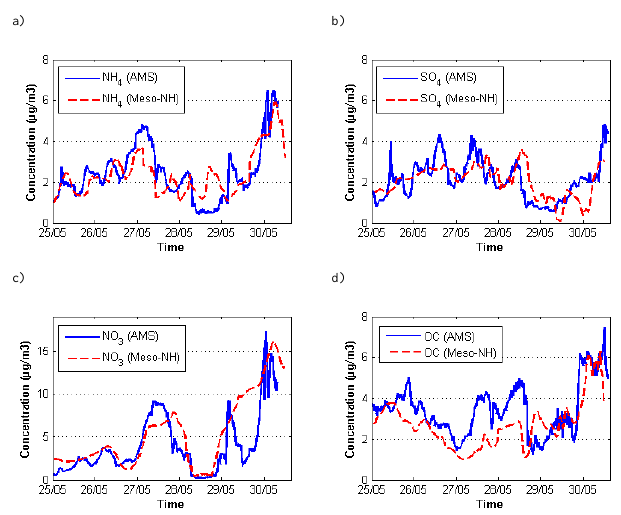
Figure 10. Evolution of (a) ammonium, (b) sulfate, (c) nitrate and (d) OC mass concentration (µgm − 3 ) obtained from AMS measure- ments (blue solid line) and simulated (red dashed line) over Cabauw between 25 and 30 May